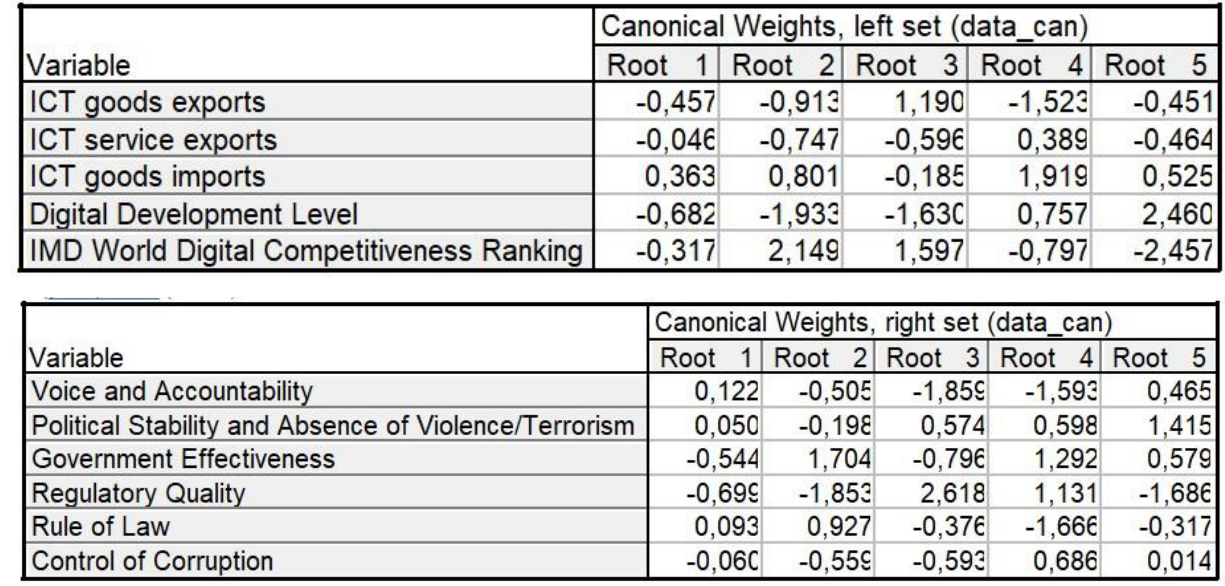
Figure 6. Canonical Contributions of Variables to the Canonical